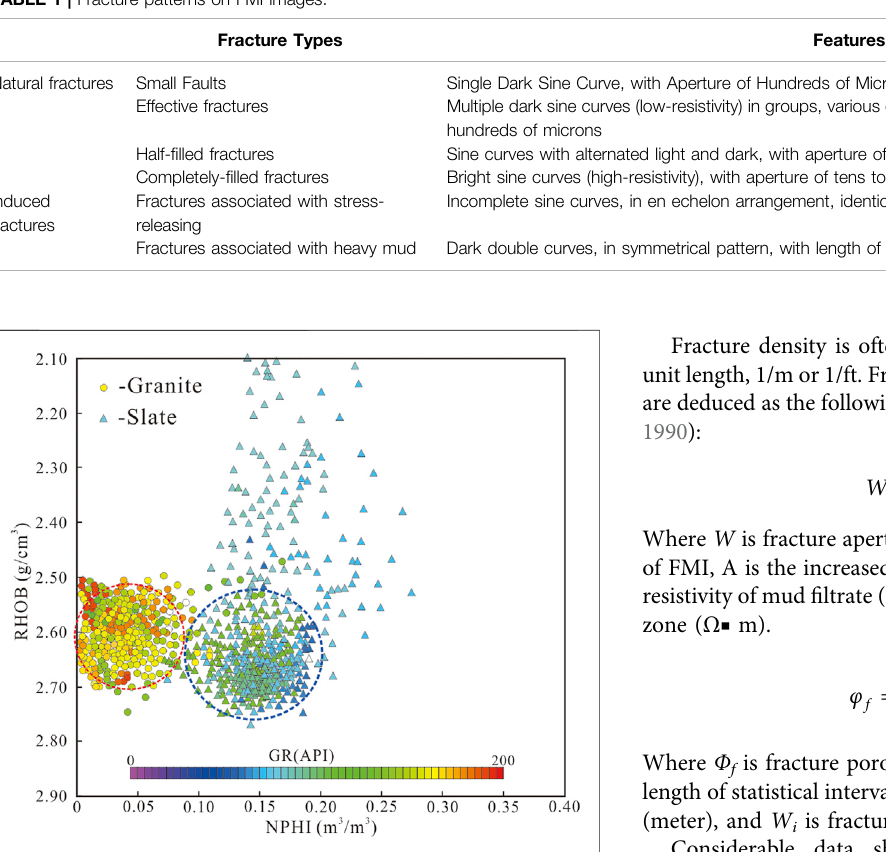
FIGURE 3 | Cross plot of RHOB-NPHI from FMI logging data (N = 694).